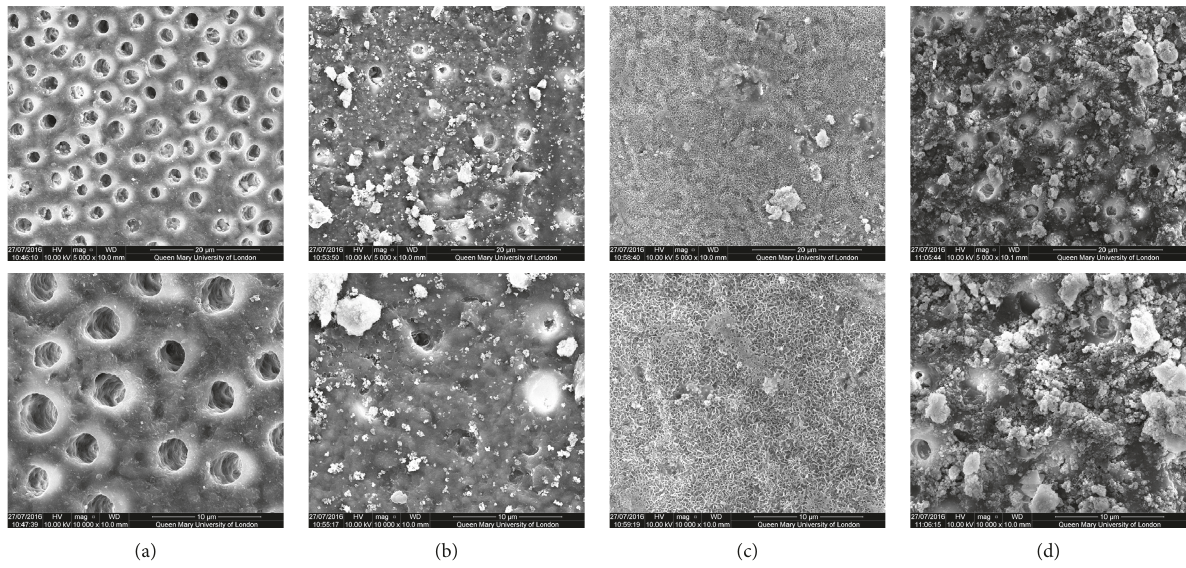
Figure 5: SEM images of the dentine surface morphology in disc 5 treated with an amorphous chloride glass-based toothpaste at 5000x (top) and 10000x (bottom) magnifications. (a) Control; (b) after brushing with a bioactive glass-based toothpaste; (c) after brushing with a bioactive glass-based toothpaste+artificial saliva immersion for 1 hour; (d) after brushing with a bioactive glass-based toothpaste+acid challenge with 6% citric